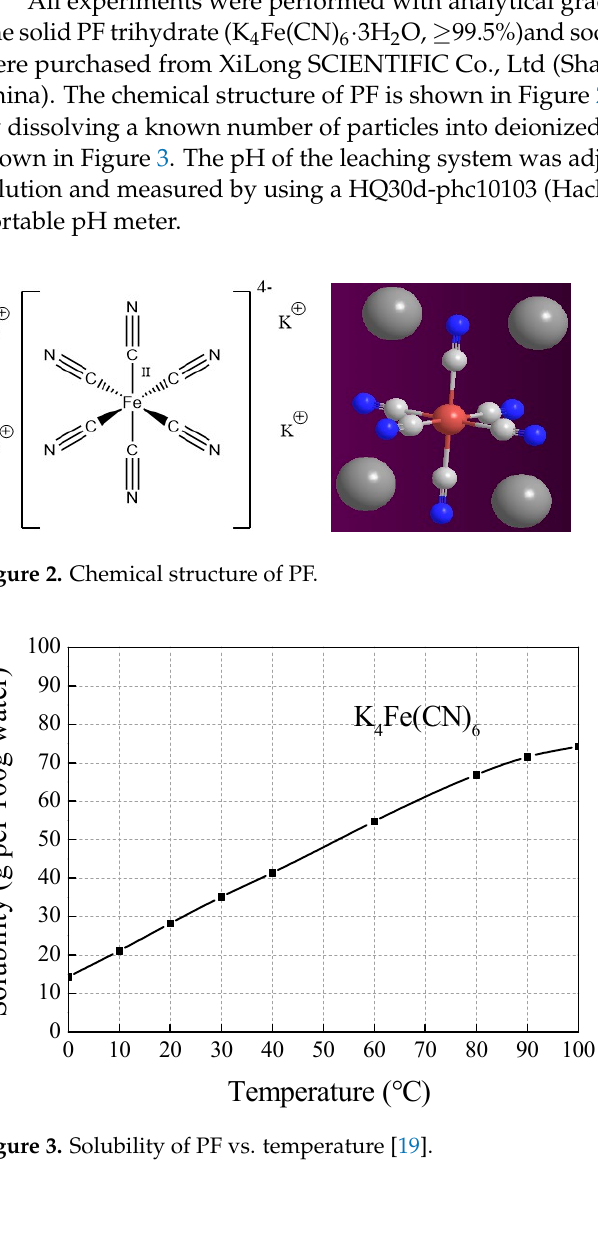
Figure 1. XRD patterns of the sample.